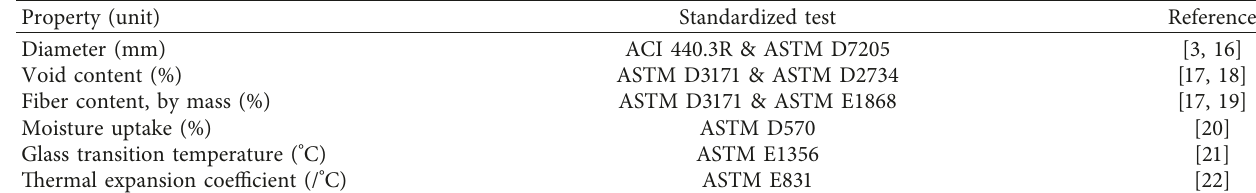
Table 1: Summary of standardized testing for physical properties.